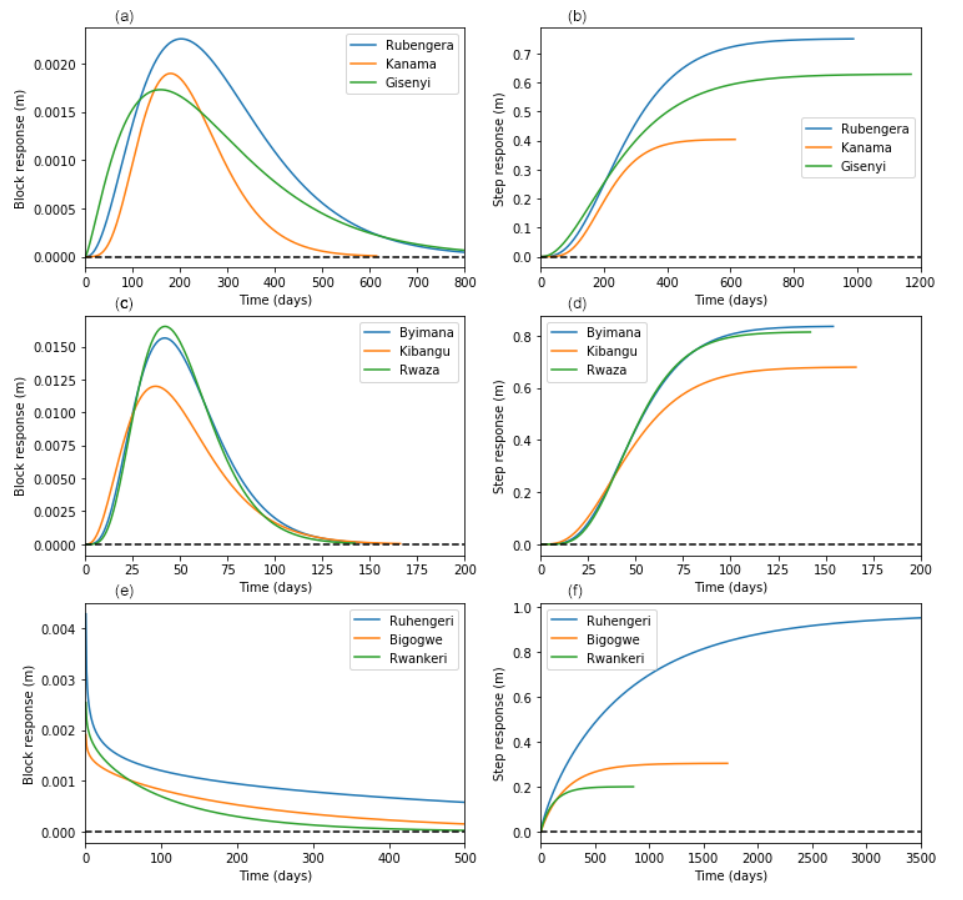
Figure B1. Groundwater response function (a) block response and (b) step response to both rainfall and potential evaporation recorded from three landslide-representative meteorological stations in Kivu catchment, (c) block response and (d) step response to both rainfall and potential evaporation recorded from three landslide-representative meteorological stations in upper Nyabarongo catchment, and (e) block response and (f) step response to both rainfall and potential evaporation recorded from three landslide-representative meteorological stations in Mukungwa